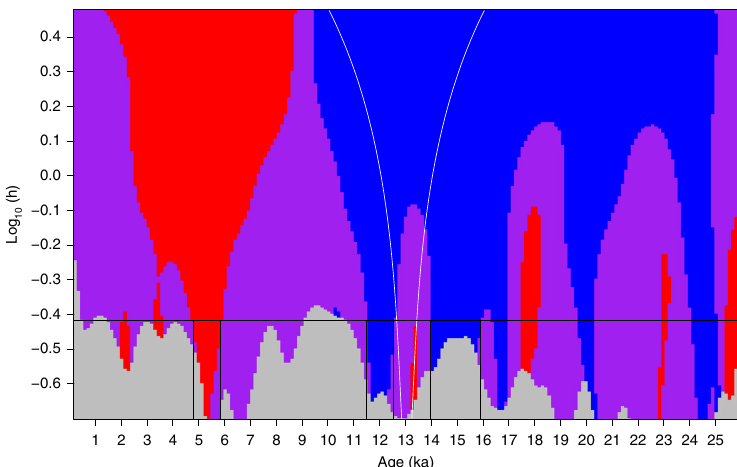
Fig. 4 SiZer map for GeoB4905-4 δ D wax . The y -axis represents the range of bandwidths ( h ) for which the data were smoothed (plotted on a log scale) and the x -axis represents age. Blue regions represent signi fi cant decreases in δ D wax (wettening), red regions signi fi cant increases in δ D wax (drying), purple regions no signi fi cant change, and grey areas indicate where the sampling resolution is too low. The black horizontal line represents the data-driven Ruppert-Sheather-Wand bandwidth 86 , the optimal smoothing (global bandwidth) for the entire data set. Time intervals where this line intersects with areas of signi fi cant increase or decrease are highlighted with vertical lines. δ D wax is adjusted for ice volume and vegetation